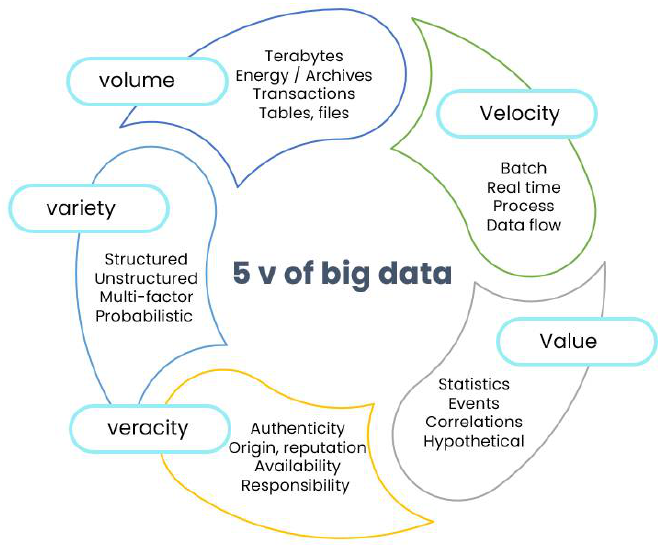
Figure 6. 3V model extended to the 5V of Big Data .